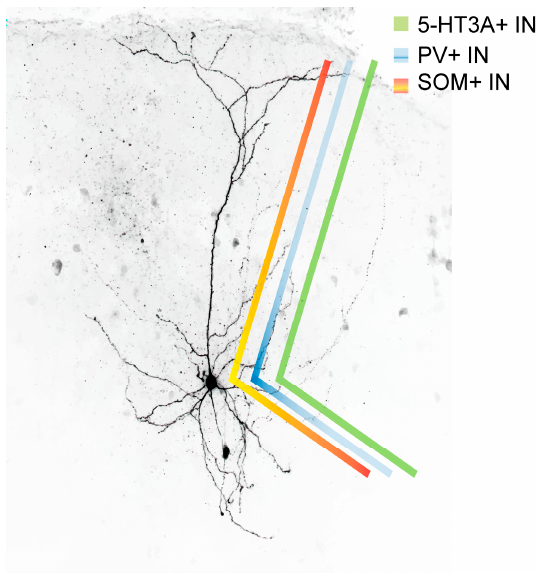
Figure 2. Postsynaptic target density of PV + (blue), SOM + (red) and 5-HT 3A receptor + interneurons (green). While PV + interneurons mainly target the proximal dendrites and soma of a given pyramidal cell, 5-HT 3A receptor-containing interneurons target, depending of the 5-HT 3A receptor + cell subtype, rather the distal and/or proximal dendrite and/or the soma. SOM + INs in turn target primarily the distal dendrites of a given pyramidal cell.